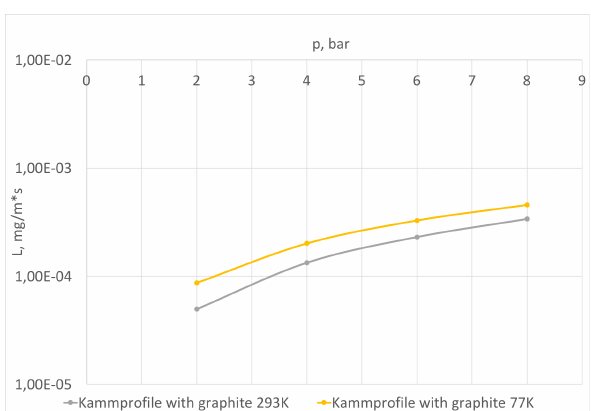
Figure 14: Characteristics of helium leakage from a flanged joint gasketed whit the kammprofile gasket layered of graphite at ambi- ent and 77 K.